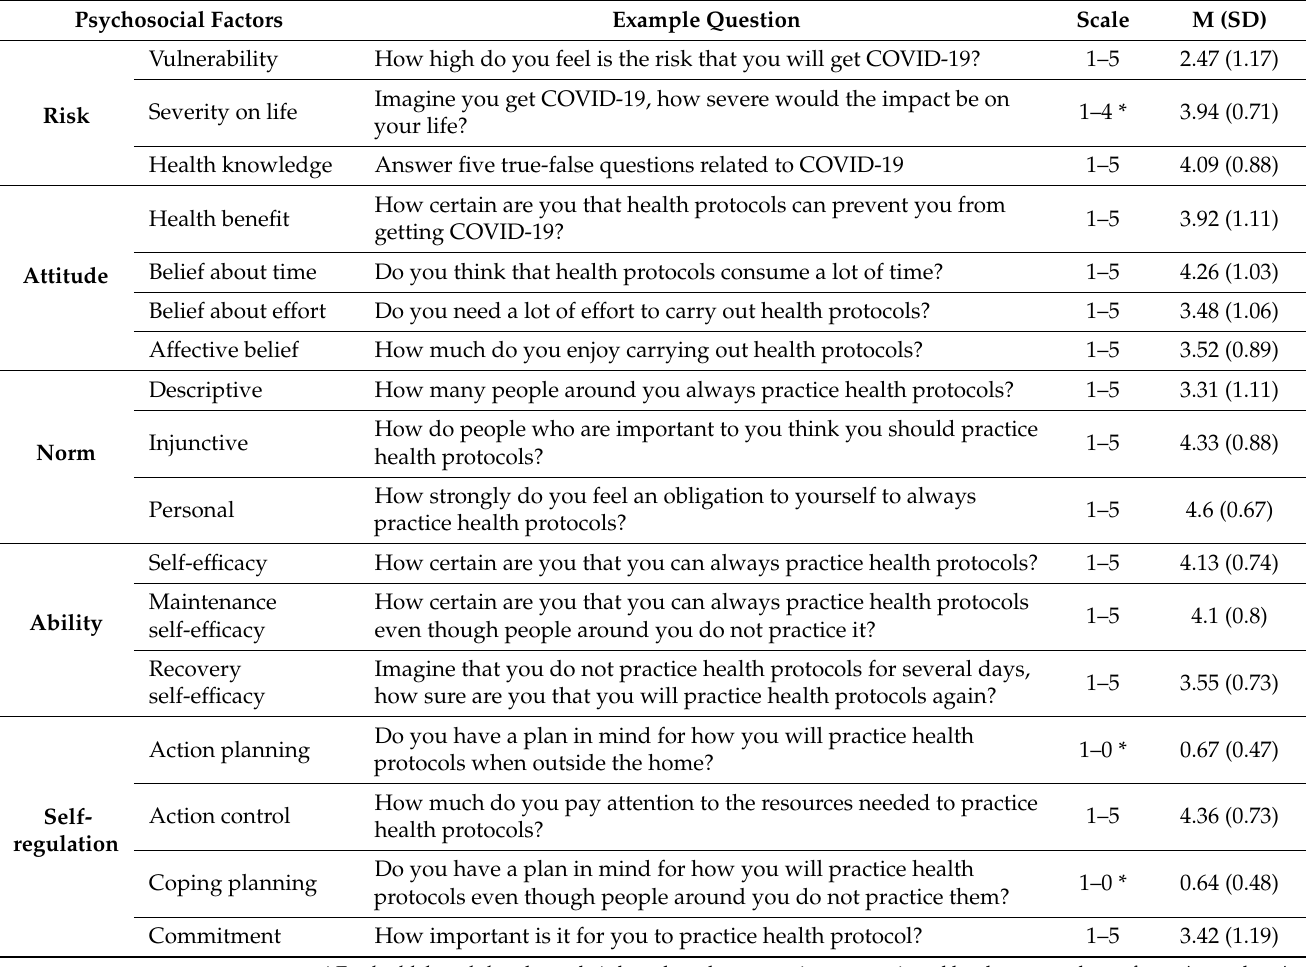
Table 1. Descriptive analyses of health protocols practiced by